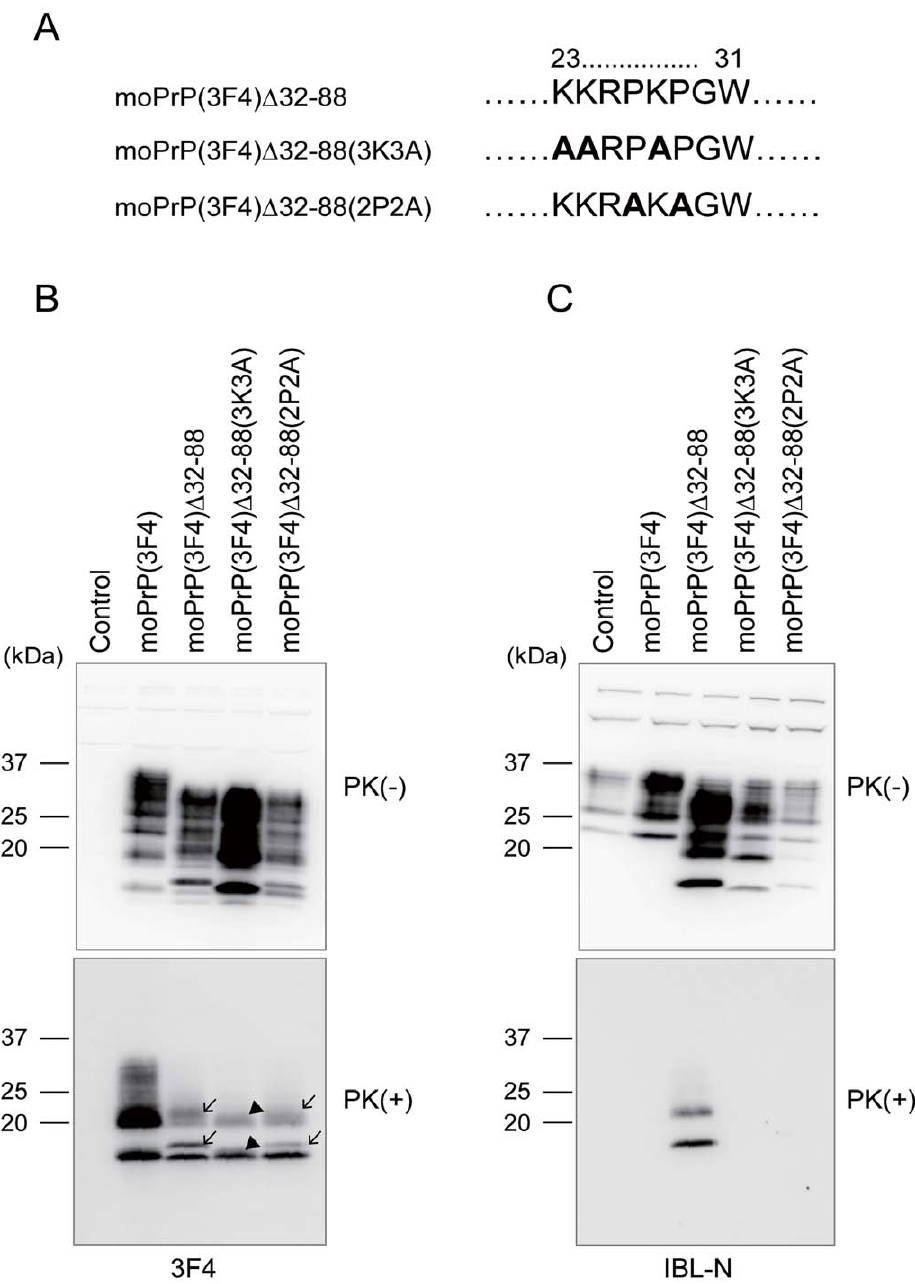
Figure 6. Lysine residues are important for the pre-OR residues 23–31 to form a PK-resistant structure in prion-infected N2a cells. (A) Amino acid sequences of the pre-OR residues 23–31 in moPrP(3F4) D 32–88, moPrP(3F4) D 32–88(3K3A) and moPrP(3F4) D 32–88(2P2A). Bold residues indicate substituted alanine residues. (B) Western blotting of N2aC24L1-3 cells transfected with control pcDNA3.1( + ) and expression vectors encoding moPrP(3F4), moPrP(3F4) D 32–88, moPrP(3F4) D 32–88(3K3A) and moPrP(3F4) D 32–88(2P2A) using 3F4 anti-PrP antibodies. The cell lysates were treated with PK at 5 m g/ml. All mutant proteins were converted into PK-resistant isoforms in N2aC24L1-3 cells. The PK treatment revealed doublet non-glycosylated and mono-glycosylated bands in moPrP(3F4) Sc D 32–88 (arrows), indicating that the pre-OR region of some moPrP(3F4) Sc D 32–88 molecules is PK-resistant. Similar doublet bands were observed in moPrP(3F4) Sc D 32–88(2P2A) (arrows). However, moPrP(3F4) Sc D 32–88(3K3A) gave rise to doublet bands with the upper band migrating very closely to the lower band (arrowheads). (C) Since substitution of proline residues into alanine residues disrupted the IBL-N epitope, the PK-resistant pre-OR residues in moPrP(3F4) Sc D 32–88(2P2A) failed to be visualized by IBL-N anti-PrP antibodies. doi:10.1371/journal.pone.0043540.g006 levels of PrP Sc D 32–93 and prion infectivity are lower in